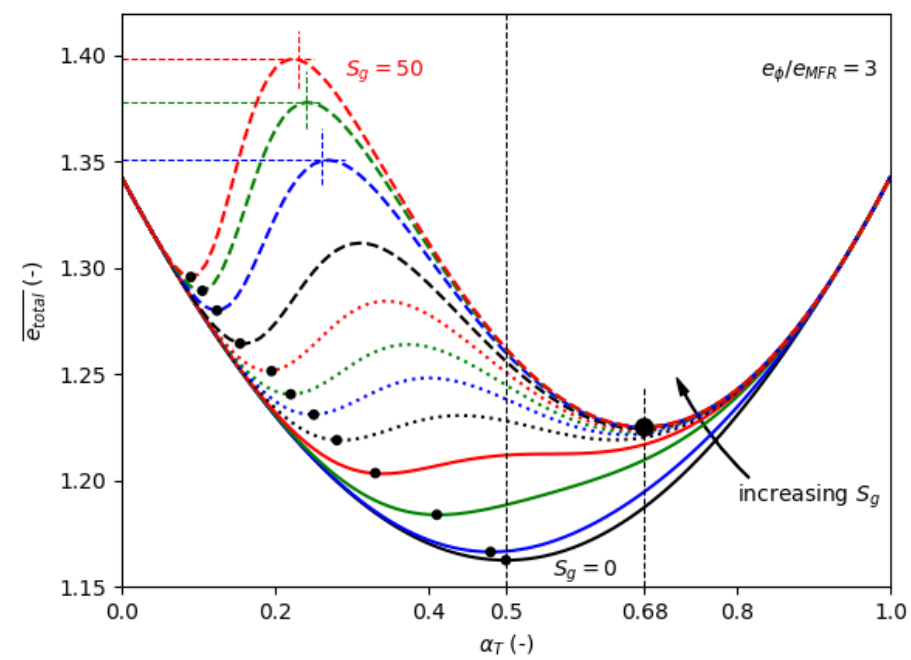
Figure 9. Influence of the geometric swirl number on the normalized total errors in A-SOFT engines for S g values in